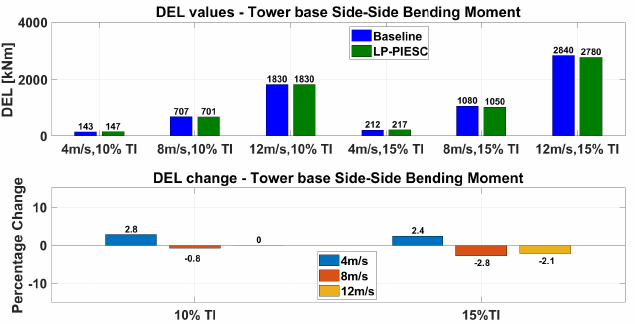
Figure 33. Tower base side-side bending moment comparison: Baseline vs. LP-PIESC. Aggregate DEL values with baseline controller and LP-PIESC ( top ), percentage change in DEL ( bottom ) for time series from 150 s to 3000